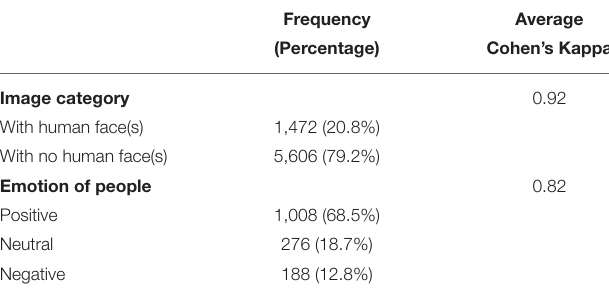
TABLE 1 | Frequency of coded variables and inter-coded